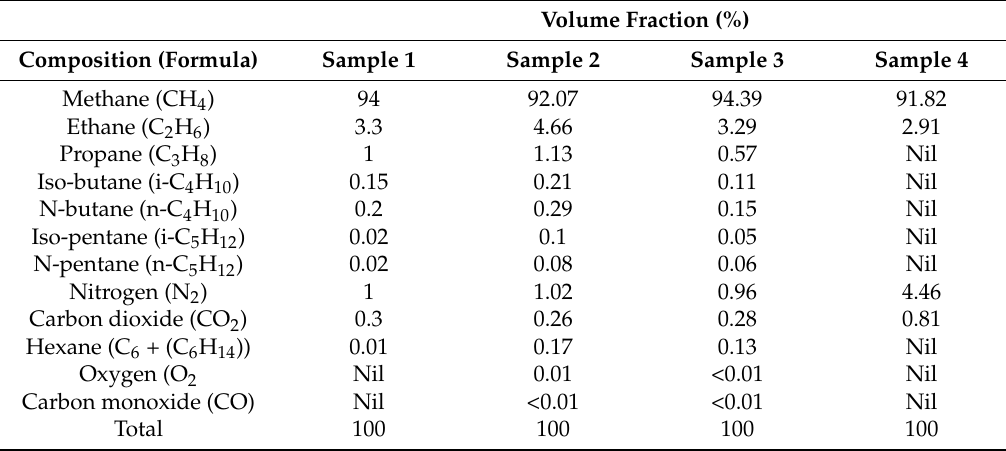
Table 6. Composition of natural gas in different samples